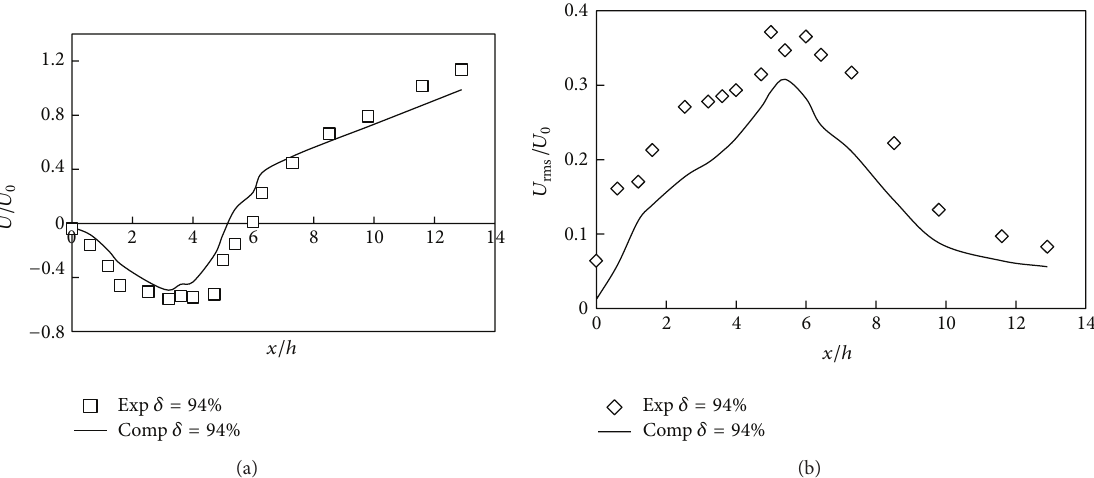
Figure 5: Comparisons between simulated and measured time-mean streamwise velocity (a) and turbulence intensity (b) distributions for the near wake of the square